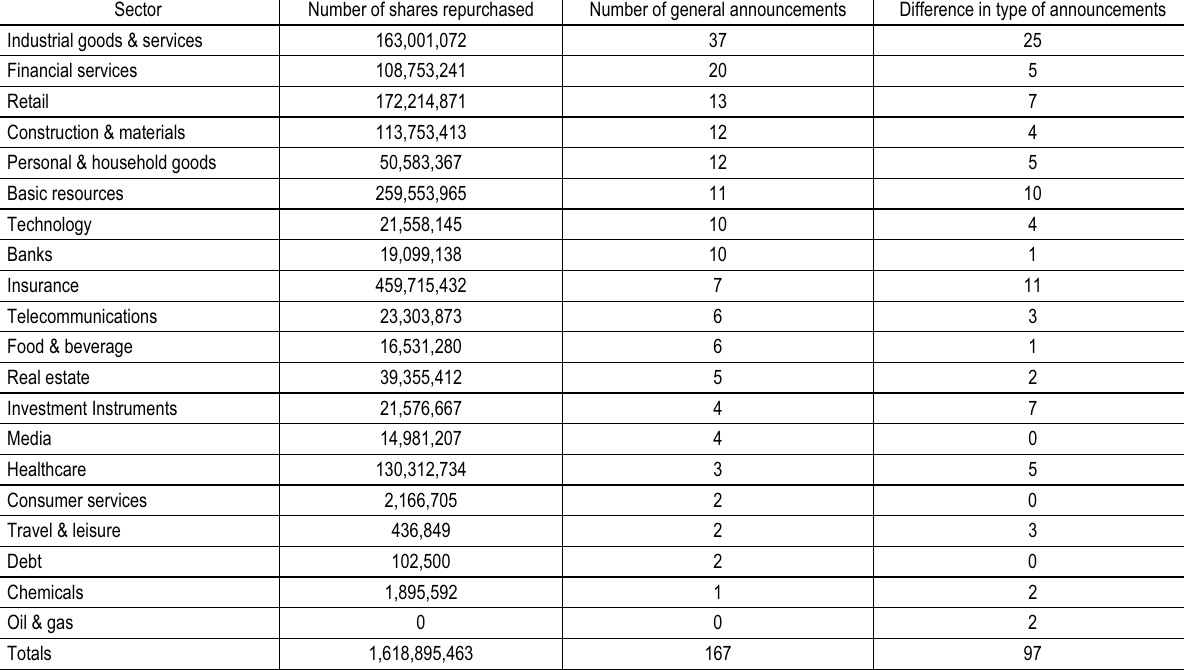
Table 4. Number of repurchase announcements in final sample per